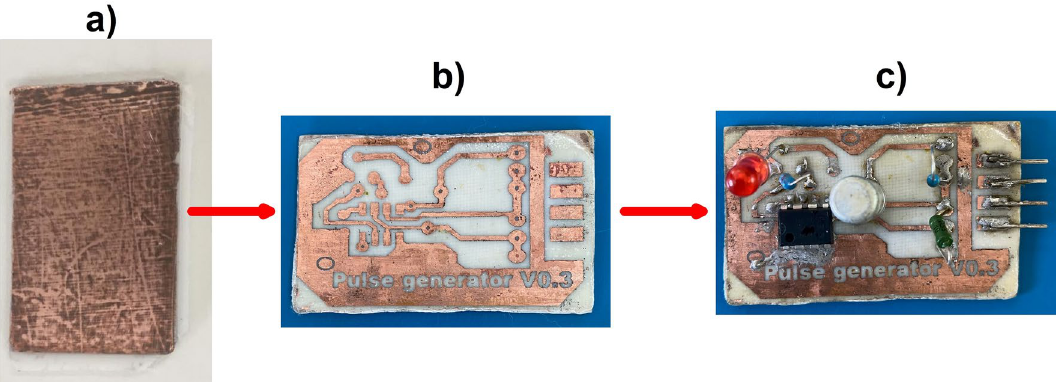
Figure 1. PCB fabrication and installation of electronic components: ( a ) Laboratory fabricated double-sided metalized PCB; ( b ) PCB with conductive copper tracks; ( c ) Electronic device fabricated in the